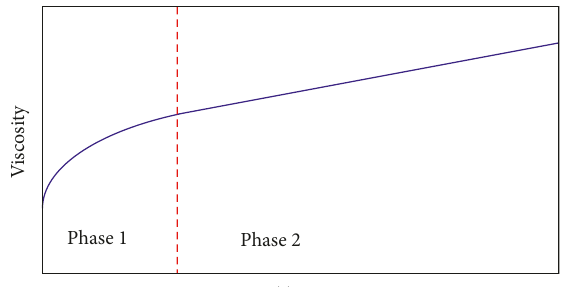
Figure 1: Typical hardening response for asphalt binder (after Glover et al.